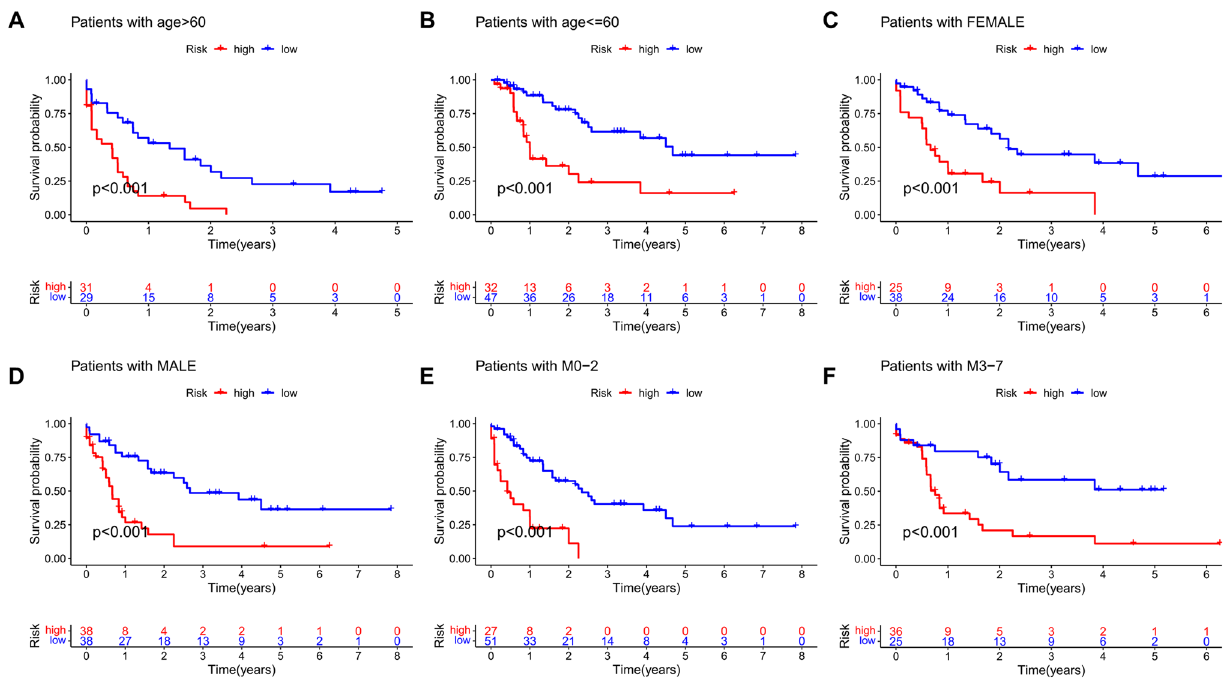
Figure 9. Survival analysis of cohorts stratified by clinicopathological factors. Kaplan–Meier survival curves showing differences in OS between the high-risk and low-risk groups in the entire TCGA AML cohort stratified by age ( A , B ), gender ( C , D ) and FAB classification ( E , F